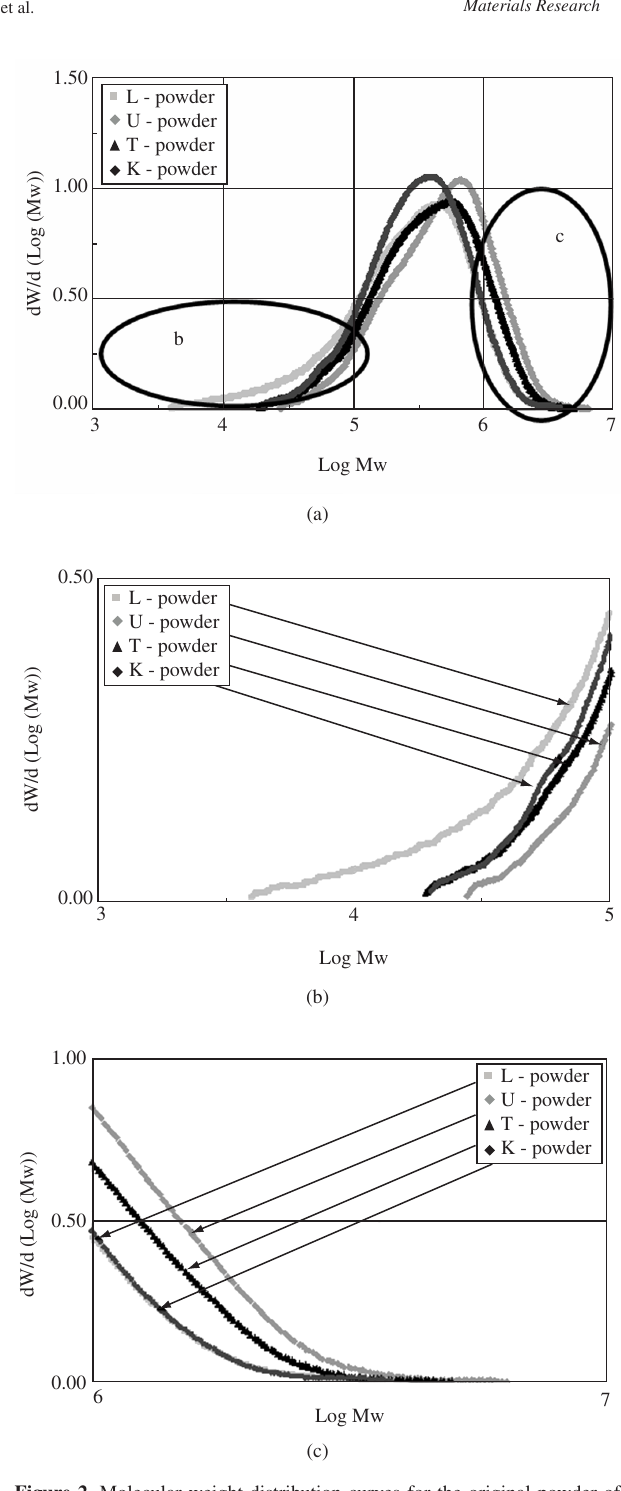
Figure 2. Molecular weight distribution curves for the original powder of all materials. (a) the entire MWD curves; b) Mw / Mn for Mw lower than 10 5 ; c) Mw / Mn for Mw higher than 10 6